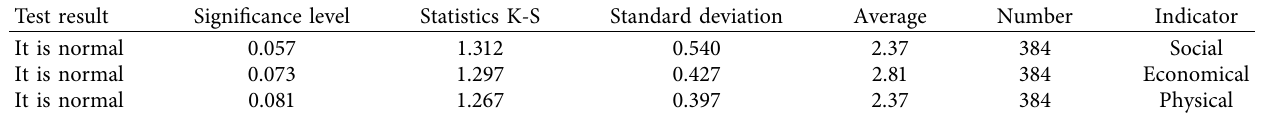
Table 1: Kolmogorov–Smirnov test a sample of resilience indicators in crisis management. Test result